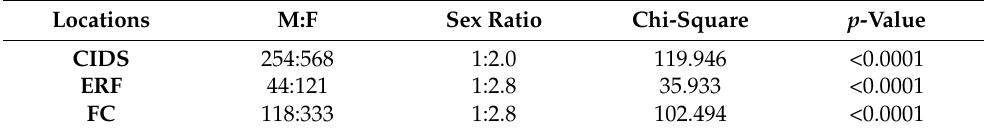
Table 3. Sex ratio of Megachile cephalotes that emerged from nests in CIDS, ERF, and FC.